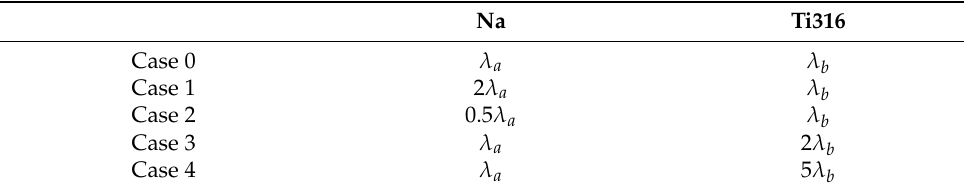
Table 9. Thermal conductivities of sodium and Ti316 for five cases.